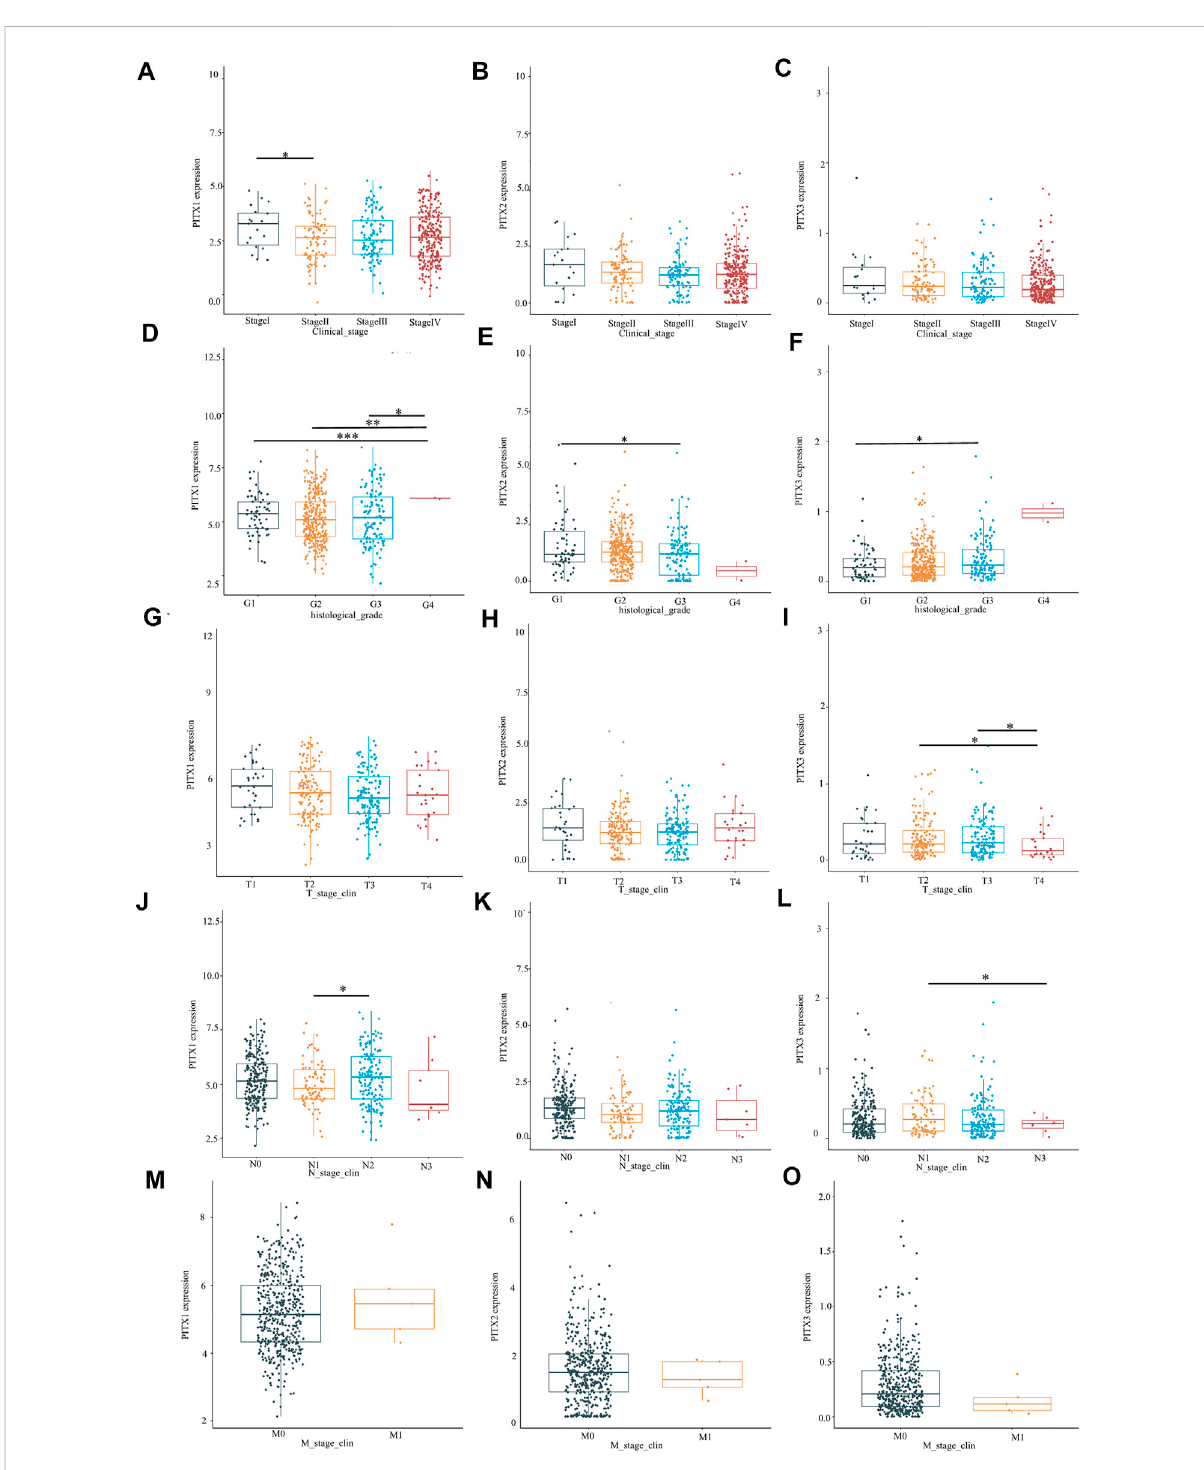
FIGURE 2 Relationship between PITX genes and clinicopathological parameters in patients with HNSC. The expression of PITX1 , PITX2 , and PITX3 markedly correlated with (A – C) clinical stage, (D – F) histologic grade, (G – I) T stage, (J – L) N stage, and (M – O) M stage. p ≥ 0.05; *, p < 0.05; **, p < 0.01; ***, p <